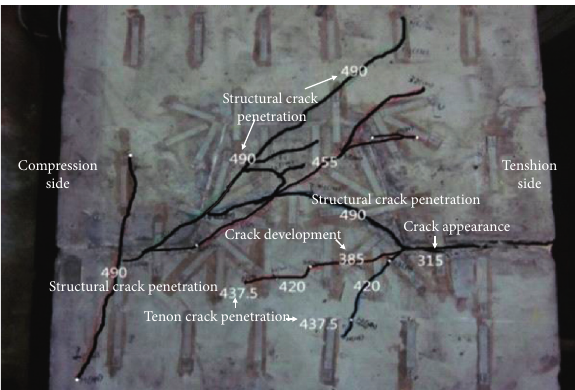
Figure 7: Crack development of specimen with modified epoxy resin.